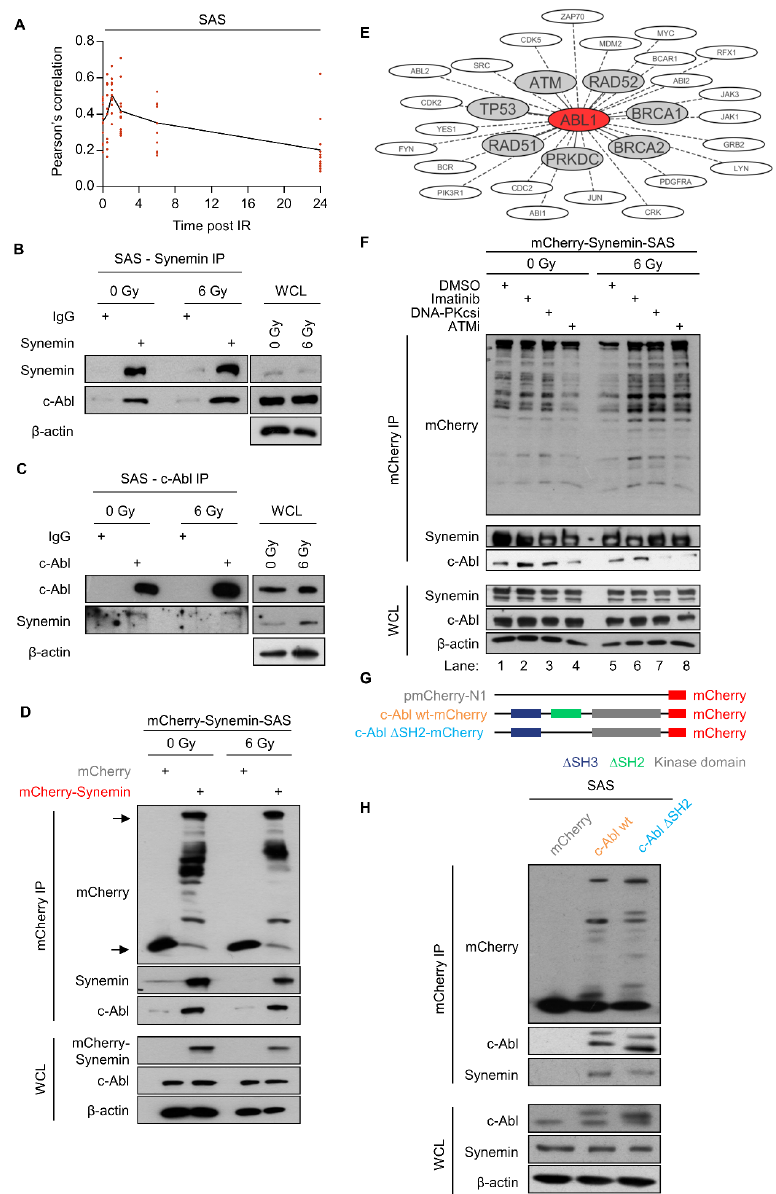
Figure 4. Synemin/c-Abl interact and co-control DSB repair and radiation survival . ( A ) Pearson’s correlation calculated from SAS cells co-stained for synemin and c-Abl at different time point post X-ray exposure (see Supplementary Figure S3) by using Fiji software. ( B ) Immunoprecipitation of synemin 1 h post 6 Gy X-rays. Western blots show expression of synemin and c-Abl. ( C ) IP of c-Abl 1 h post 6 Gy X-rays. Western blots show expression of synemin and c-Abl. ( D ) Western blots on mCherry immunoprecipitates from 6-Gy irradiated mCherry-SAS and mCherry-Synemin-SAS cells at 1 h post irradiation. β -actin served as loading control. ( E ) c-Abl interactome of DNA repair proteins calculated by Cytoscape. ( F ) Western blots on mCherry immunoprecipitates from mCherry-Synemin-SAS cells after a 1-h pretreatment with Imatinib, DNA-PKcsi or ATMi alone or in combination with 6 Gy X-rays. ( G ) Design of di ff erent c-Abl constructs. ( H ) IP of SAS cells expressing mCherry, c-Abl WT-mCherry, and c-Abl ∆ SH2-mCherry. IP, immunoprecipitation; WCL, whole cell